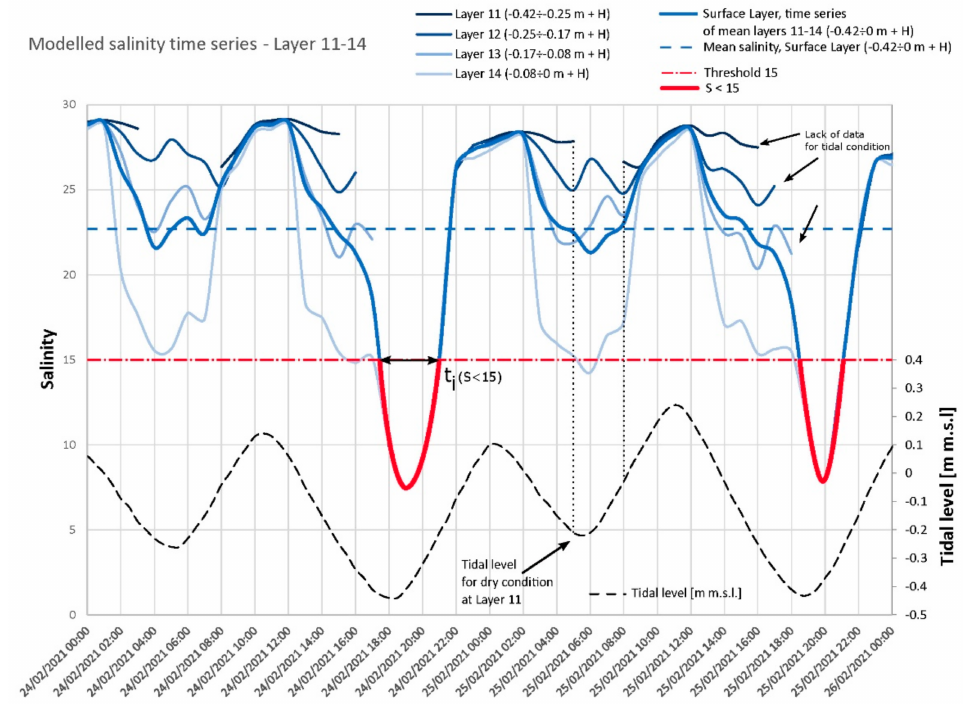
Figure 5. Numerical modeled time series of salinity for different vertical layers (11–14, wet or dry as a function of local bathymetry and tidal level) and their mean salinity values (Surface Layer). Identification of events (duration, t i ) with salinity lower than a defined threshold (15). Evaluation of mean salinity values over